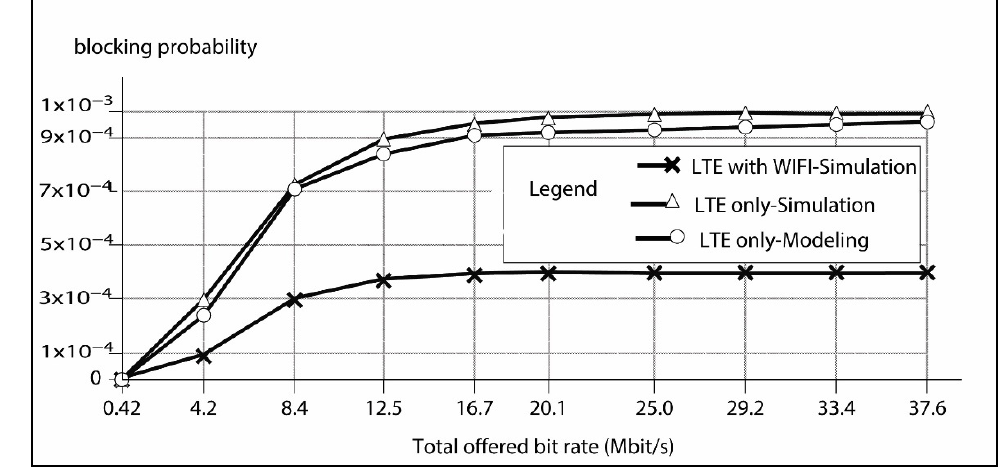
Figure 11. Blocking probability comparison.